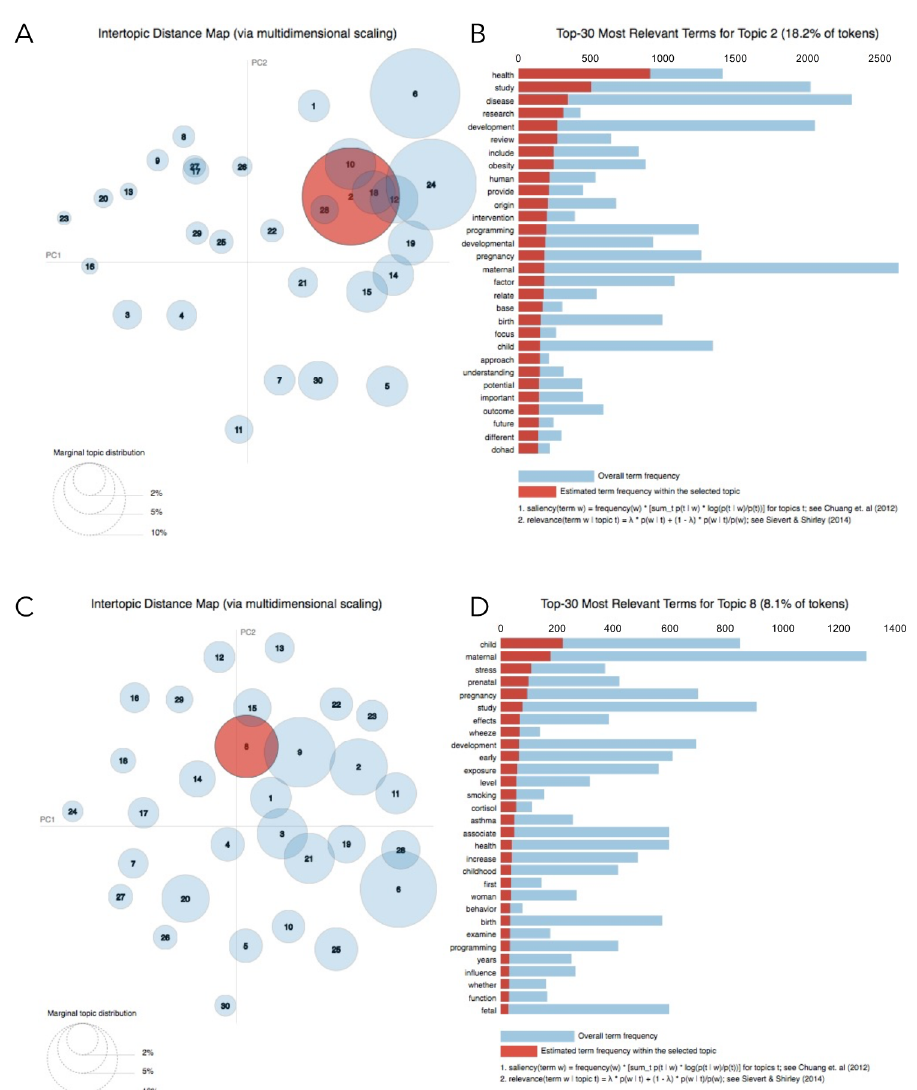
Figure 4. Results for text mining Model 1 ( A , B ) and Model 2 ( C , D ) for 30 topics via pyLDAvis. ( A , C ) Each topic in the PC plots are represented as a circle (circle size = the frequency of terms that the topic spans over the entire corpus). The distance between circles (topics) indicates their (dis)similarity (closer = more similar). ( B , C ) The histograms display the top 30 most relevant terms for the selected topic (in this example, the red circle in panels A , C ). The term frequency within that topic is represented by the horizontal red bars. The blue bars represent the frequency of the term across the whole corpus. PC1, principal component 1. PC2, principal component 2.